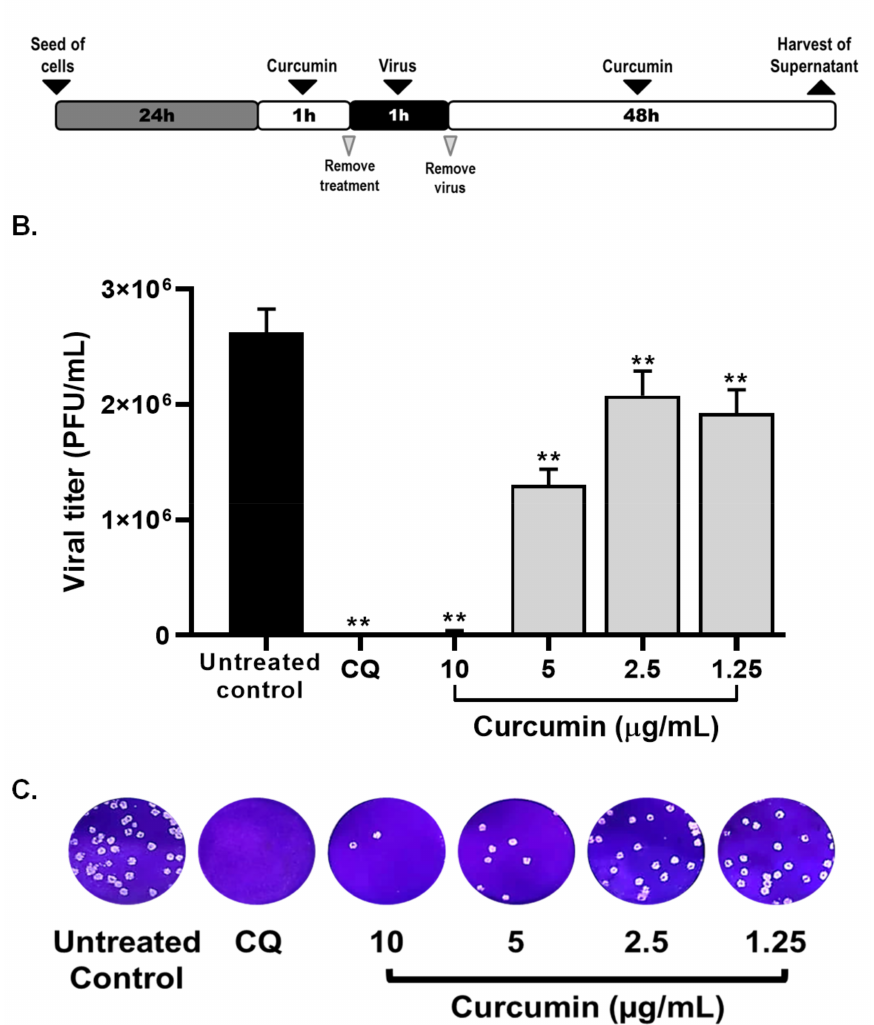
Figure 3. Antiviral effect of curcumin against SARS-CoV-2 by pre–post infection treatment. ( A ) Repre- sentative scheme of pre–post infection treatment. ( B ) The figure shows the reduction of D614G strain titer (PFU/mL) on Vero E6 supernatants after pre–post infection treatment with curcumin (n = 4). Chloro- quine (CQ) was included as a positive control of viral inhibition. Data were presented as median ± IQR (interquartile range). Mann–Whitney test ** p ≤ 0.01. Inhibition percentages of 99%, 51.3%, 22.2%, and 27.8% were obtained at 10, 5, 2.5, and 1.25 µ g/mL of curcumin, respectively. ( C ) Representative plaques on Vero E6 cells of pre–post infection treatment of curcumin against D614G